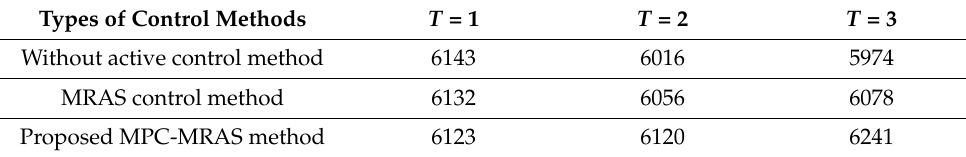
Table 2. Comparison of the output power using different control methods.